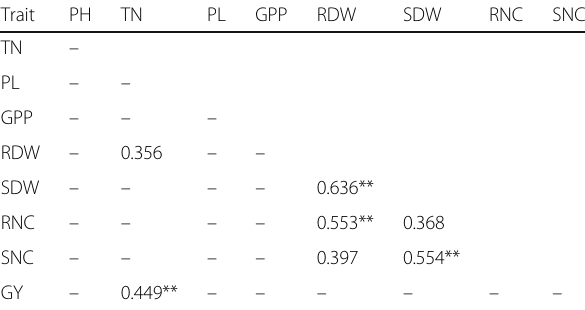
Table 3 Correlation among traits (all correlations shown are significant at P <